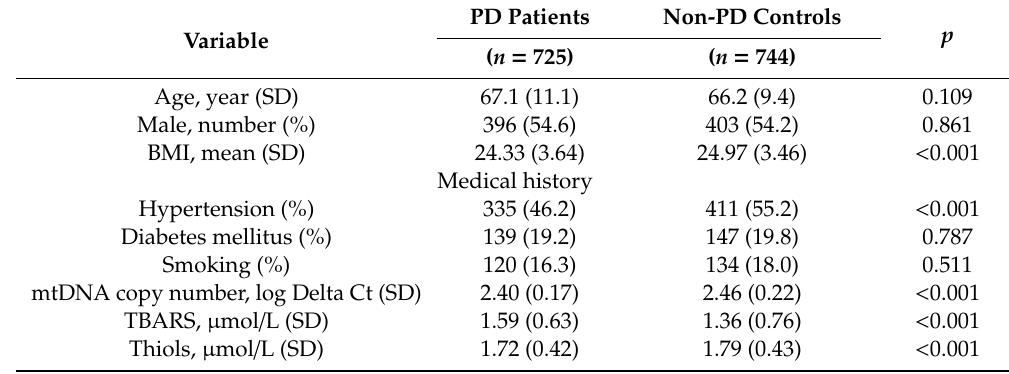
Table 1. Demographics, mitochondrial DNA (mtDNA) copy number, thiobarbituric acid reactive substances (TBARS), and thiols of Parkinson’s disease (PD) patients and non-PD